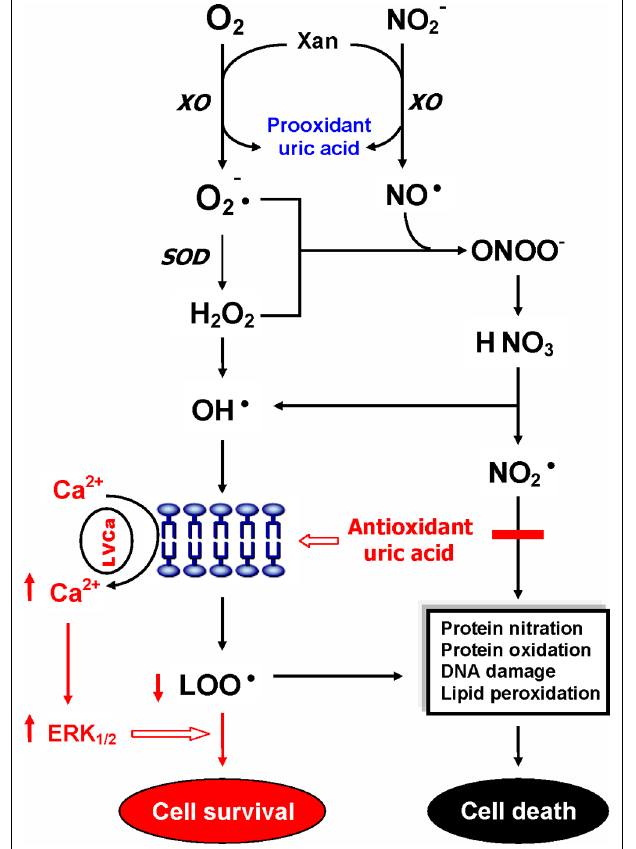
FIGURE 3 | Dual role of uric acid in the antioxidant defense system. Uric acid can neutralize peroxynitrite and hydroxyl radicals to inhibit protein nitration and lipid peroxidation, respectively. At increased levels, however, uric acid may be considered as a marker of oxidative stress due to accumulation of reactive oxygen species. CAT, catalase; GSH, glutathione; ERK 1 / 2 , extracellular signal-regulated kinases½, LOO • , lipid peroxyl radical; LVCa, L-type voltage-gated calcium channel; NO, nitric oxide; NO • 2 , nitrogen dioxide radical; NO − 2 , nitrite; O − 2 , superoxide anion; ONOO − , peroxynitrite; OH • , hydroxyl radical; SOD, superoxide dismutase; Xan, xanthine; XO, xanthine oxidase. Reprinted by permission fromYao etal.